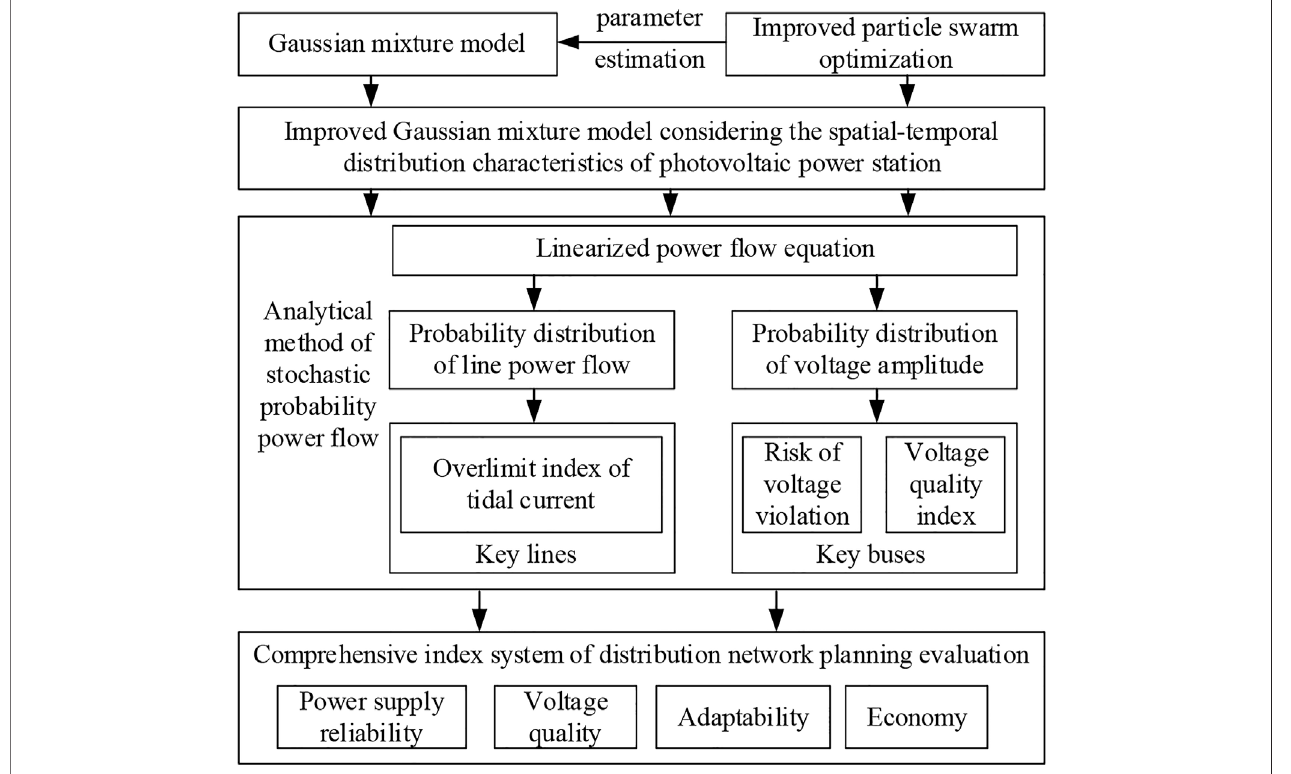
FIGURE 2 | Flow chart of the comprehensive evaluation of the distribution network.